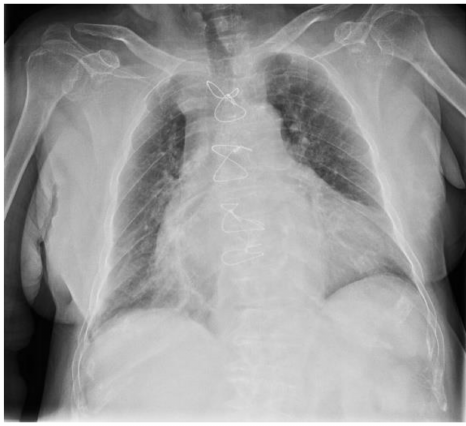
Figure 2. Thoracic-abdominal-pelvic CT showing two lymphomatous masses in right superior lobe with pleural origin (red arrows); no splenomegaly or intra-abdominal and mediastinal lymphadenopathies ( A ); Thoracic-abdominal-pelvic CT showing right pleural e ff usion, after thoracentesis and intravenous diuretic therapy ( B ).